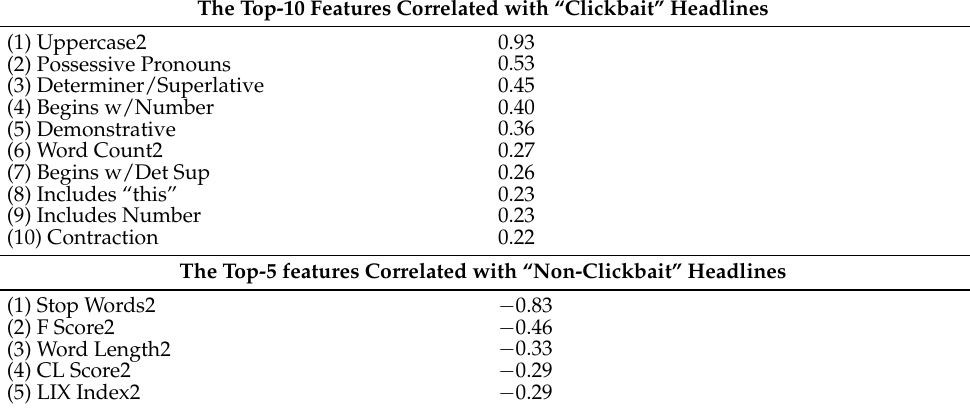
Table 3. Top-15 features.